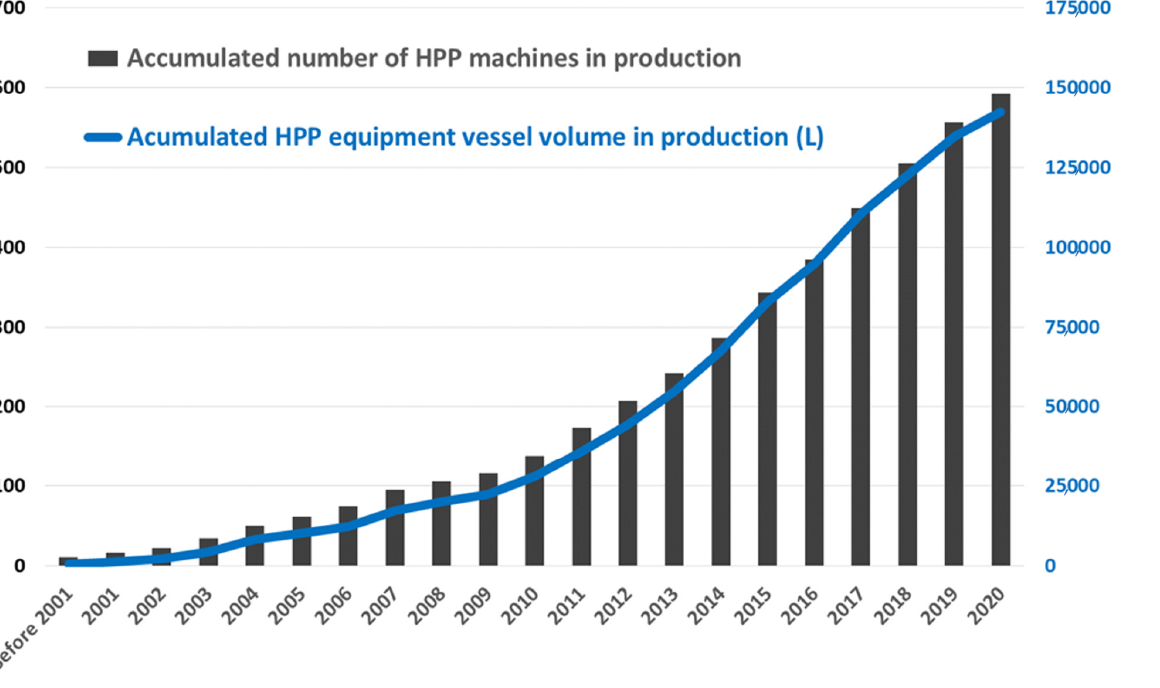
Figure 5. Evolution of number of industrial high pressure processing machines in production across time, accumulated and total volume of vessel (Hiperbaric and all others HPP machinery vendors).